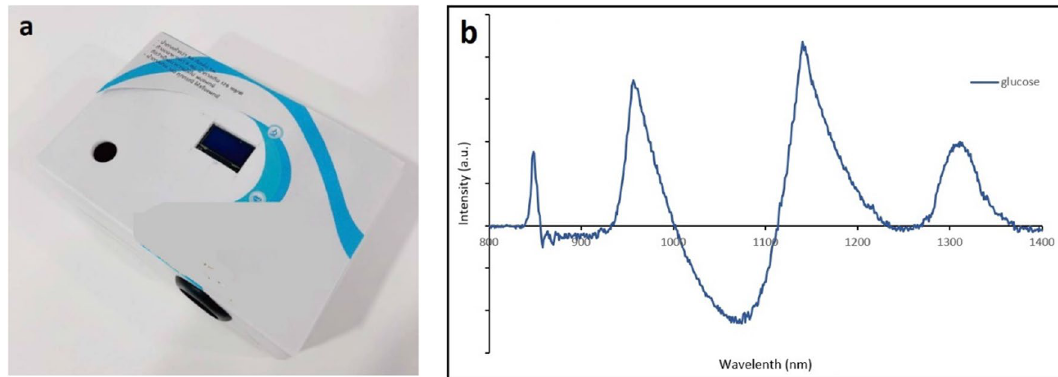
Figure 5. ( a ) The box enclosing the circuits described in Fig. 1. The light is scattered and absorbed in the human finger before entering the photoreceivers of each band. ( b ) Absorbance spectrum of glucose